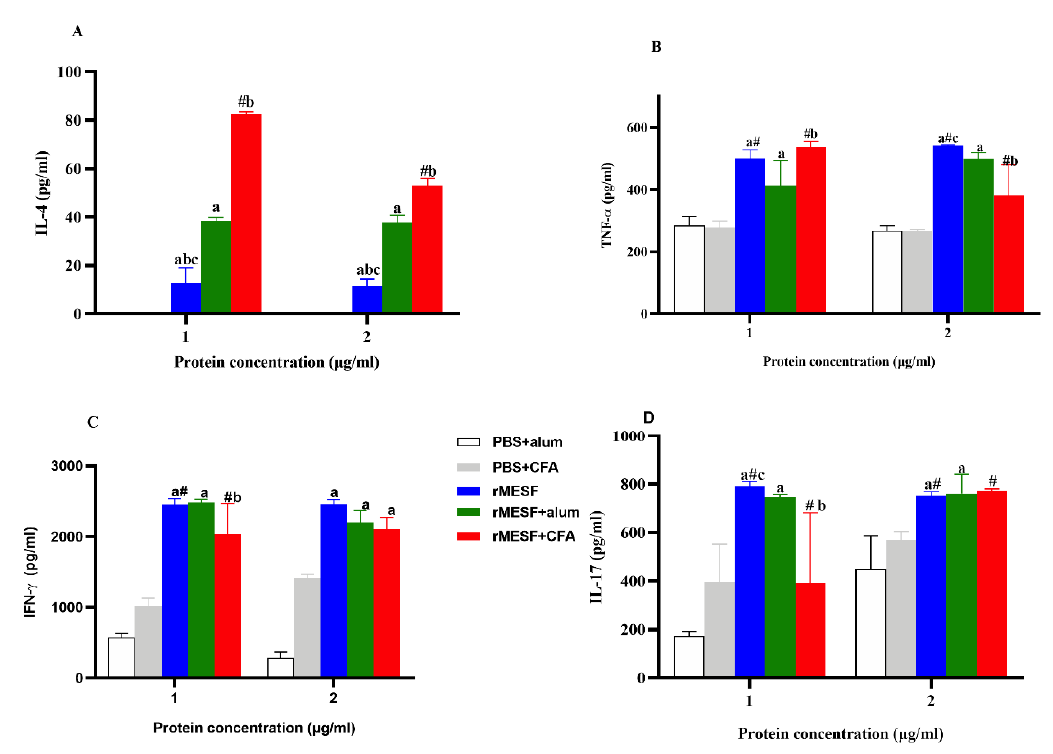
Figure 5. Cytokine levels quantified by ELISA sandwich. Production of ( A ) IL-4, ( B ) TNF-α, ( C ) IL-17 and ( D ) IFN-γ, present in the supernatant of splenocytes stimulated in vitro with 1 or 2 μg/mL of rMESF multiepitope fusion proteins for 72 h. Splenocytes were collected after 30 days of the last immunization (n = 5 mice/group). The absorbance was measured at 450 nm. Symbols and letters indicate statistically significant values with p values raging from <0.05 to 0.0001 (for more details read the text) as compared with the respective mice group. # vs. PBS+CFA, a vs. PBS+alum, b vs. rMESF+alum, c vs. rMESF+CFA. PBS, phosphate-buffered saline. CFA, complete Freund’s adjuvant. Results are plotted as mean ± standard deviation.